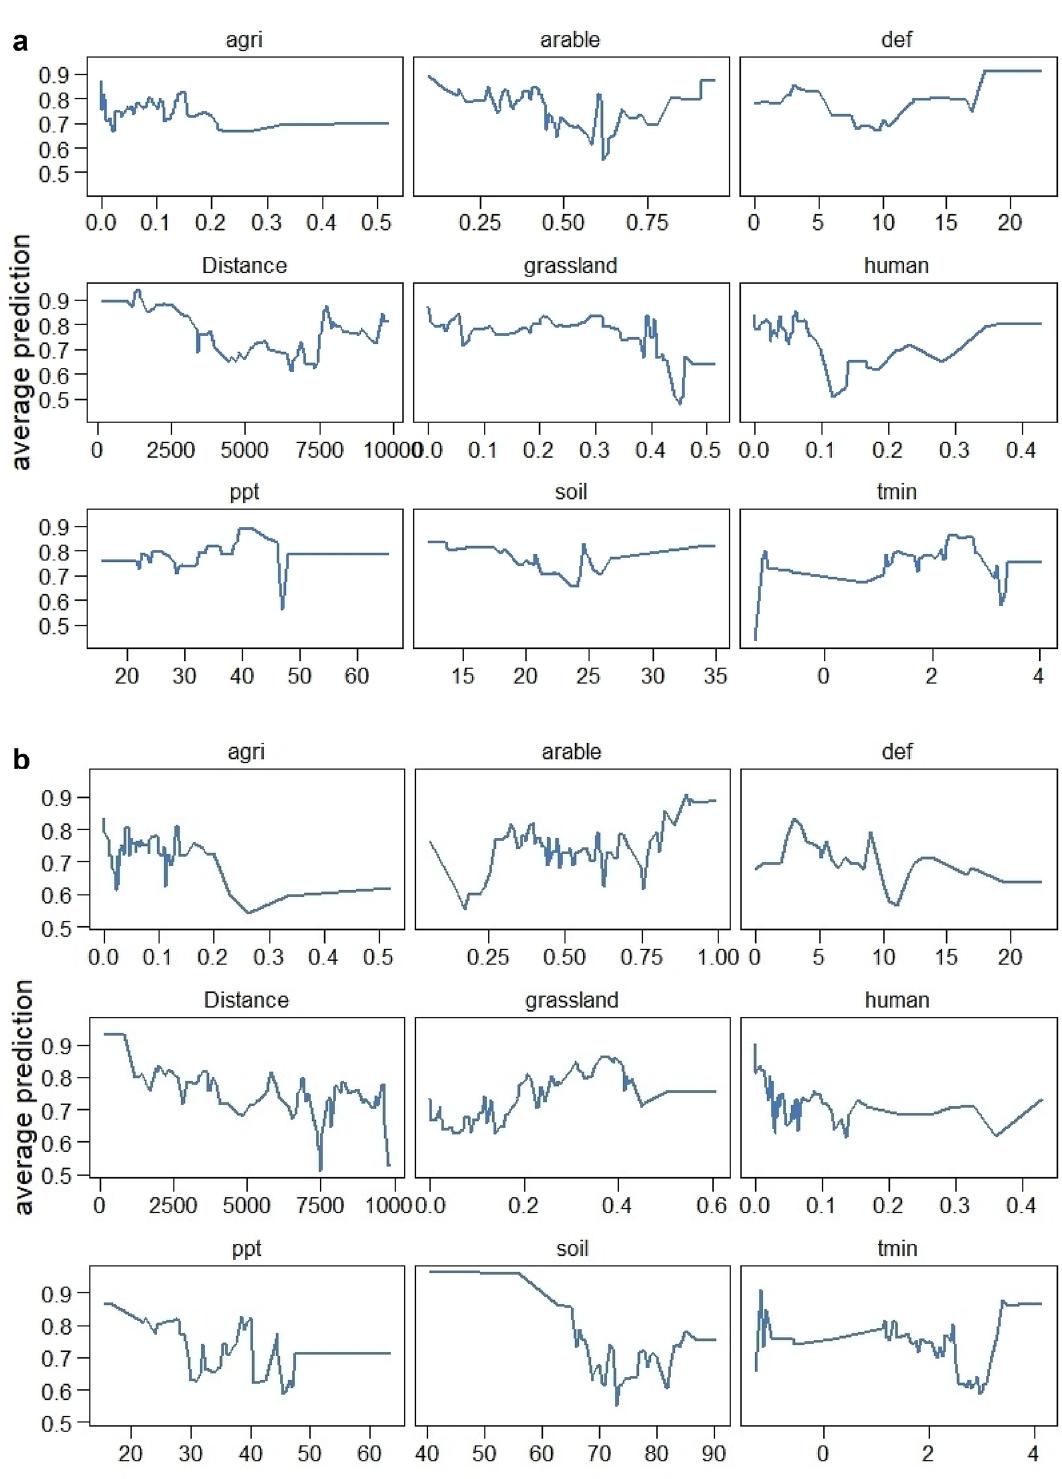
Figure 3. Partial dependence plots showing average predictions of nest occupation in years 2009–2018 (a) and for one season (2016) (b) . Lines show average predictions for continuous predictors, assuming mean values of all remaining predictors. For categorical predictors we showed mean predicted survival probability assuming constant level of other predictors for each group. Abbreviations used in the table: agri—cover of other agricultural lands, arable—cover of non-irrigated arable lands, def—average water deficit during breeding season, distance—ln distance to the nearest landfill, grassland—cover of pastures and meadows, human—cover of highly human changed areas, ppt—average accumulated monthly precipitation during breeding season, soil moisture—average soil moisture at the end of each month during breeding season, tmin—average minimum temperature during breeding